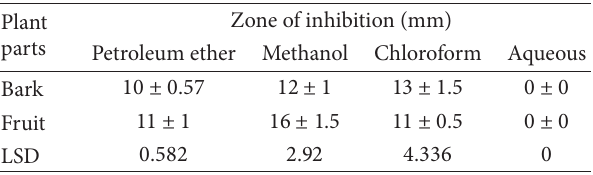
Table 8: Zone of inhibition produced by extracts of different parts of C. ambrosioides against A.